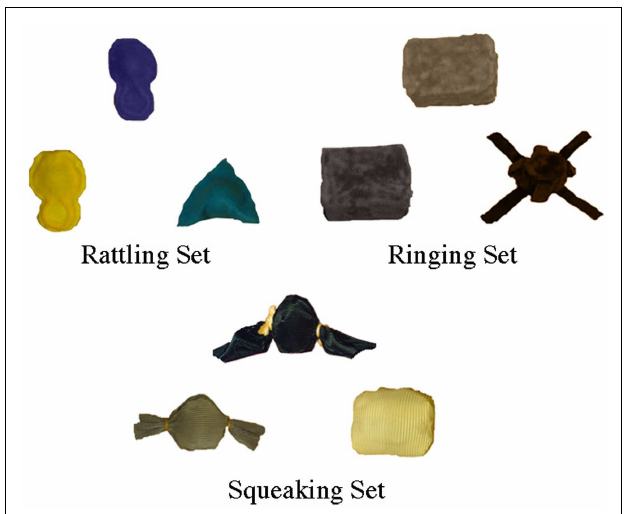
FIGURE 1 |The three object sets: the ringing set, the rattling set, and the squeaking set. Within each set, the objects are arranged in the following manner: target object (top center), high-similarity test object (bottom left), and the low-similarity test object (bottom right).